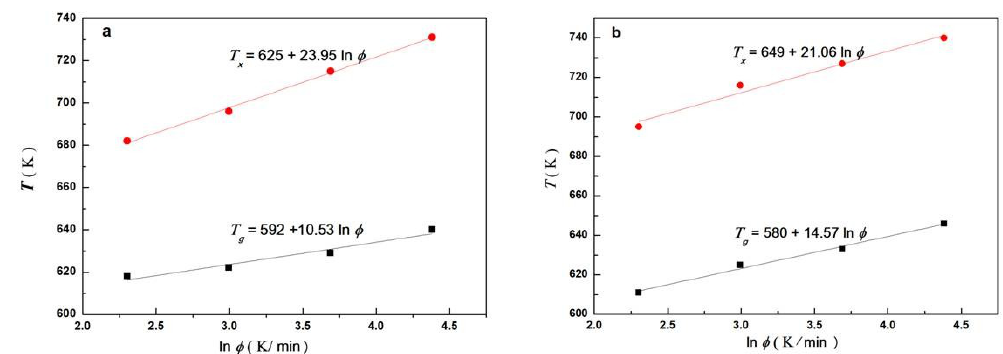
Figure 4. Plots for T g and T x vs. ln ϕ of two materials: ( a ) the metallic glass Zr 41.2 Ti 13.8 Cu 12.5 Ni 10 Be 22.5 ; ( b ) the W particles/Zr 41.2 Ti 13.8 Cu 12.5 Ni 10 Be 22.5 metallic glass composite.